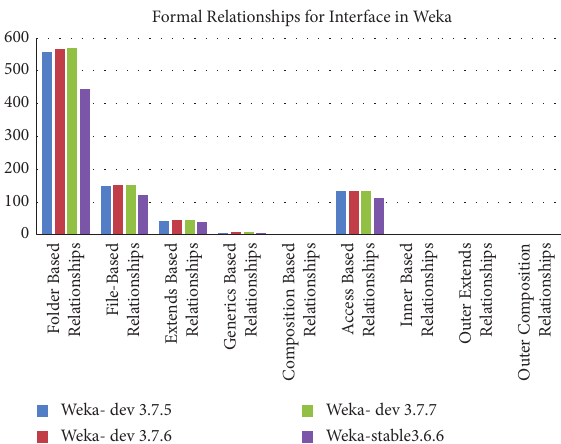
Figure 23: Count of formal relationships for interface in weka.